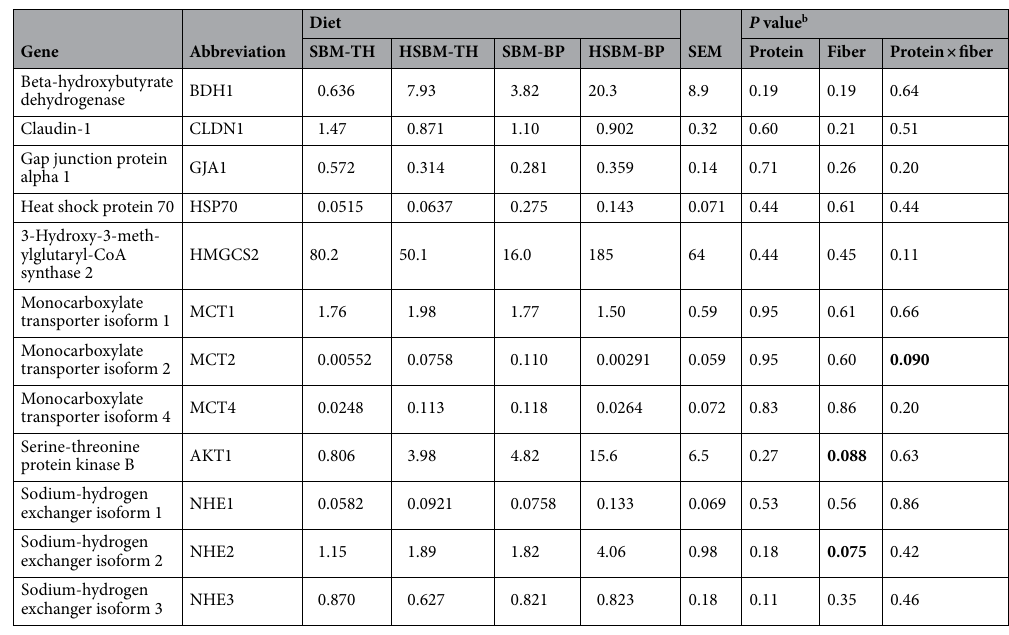
Table 6. LS means for rumen epithelial gene expression (2 −ΔCt ) as differentiated by diet along with P values for the effects of protein source, fiber source, and the interaction of protein and fiber source a . a HSBM-TH heat-treated soybean meal and timothy hay, SBM-TH soybean meal and timothy hay, HSBM-BP heat-treated soybean meal and beet pulp, SBM-BP heat-treated soybean meal and beet pulp. b Bolded values indicate significance or a